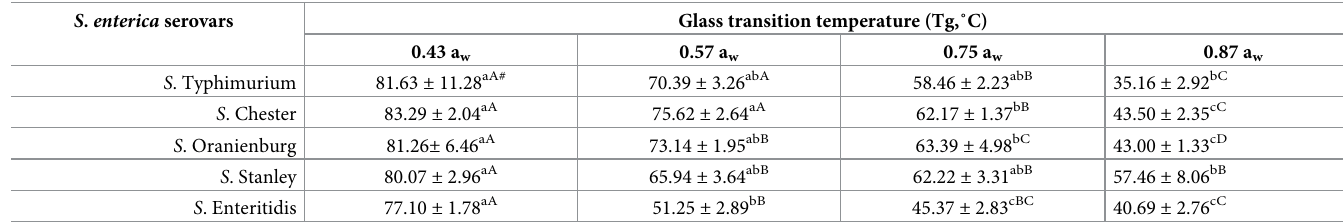
Table 1. Relationship between water activity (a w ) and observed glass transition temperature ( T g ) of Salmonella enterica serovar Typhimurium, S . Chester, S . Ora- nienburg, S . Stanley, and S . Enteritidis. S . enterica serovars